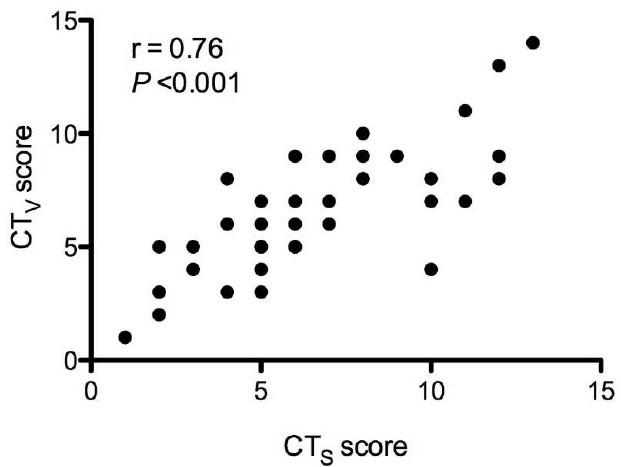
Figure 3. Pearson’s correlation for CTs and CTv scores.